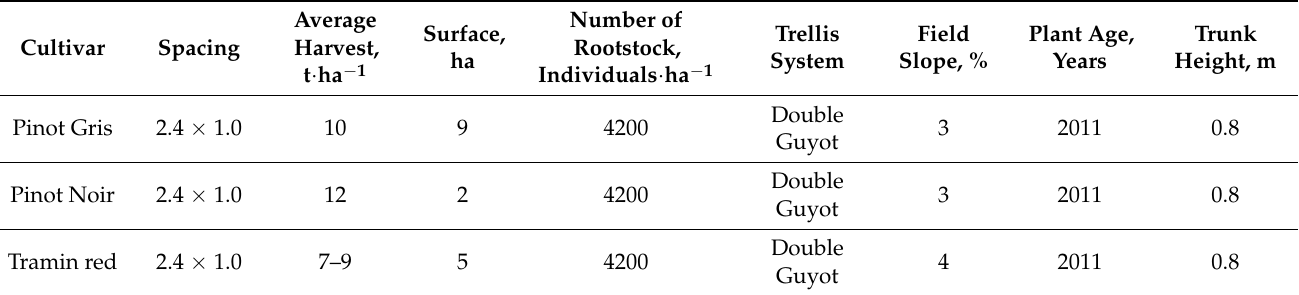
Table 1. Characteristics of